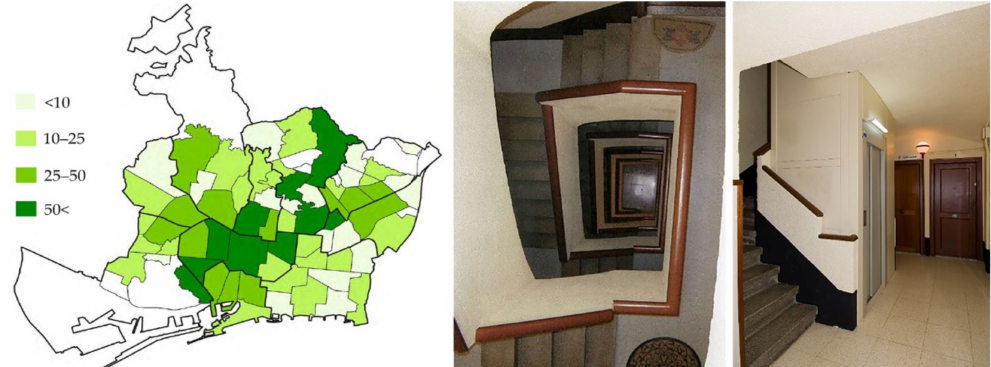
Figure 1. Map: accessibility interventions by neighborhood (2010–2018). Before and after pictures of the installation of a new elevator in the stairwell of a building with four apartments per floor. Source: Rehabilitation study [34].